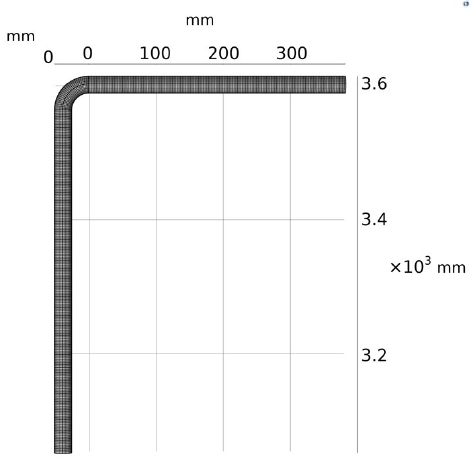
Figure 1. Elbow calculation model and mesh division.